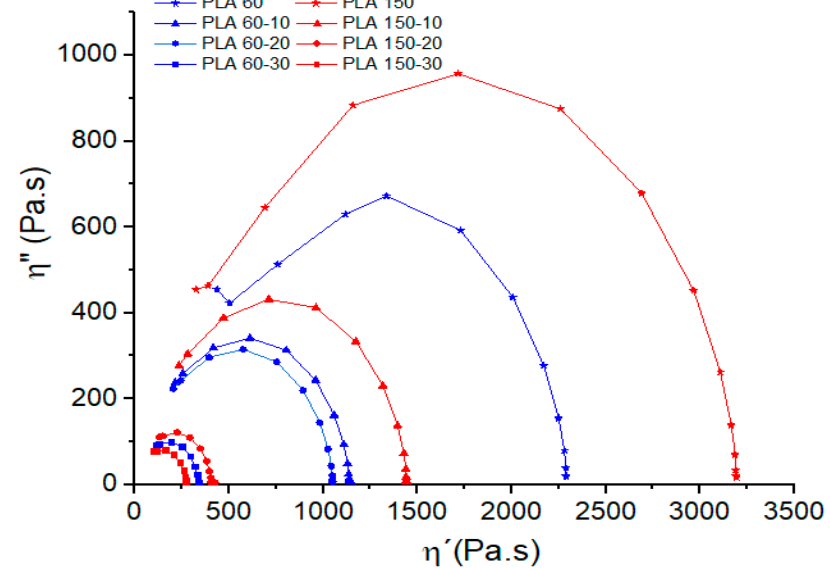
Figure 4. Cole–Cole diagrams of PLA and PLA with ATBC at 10, 20 and 30% extruded to 60 and 150